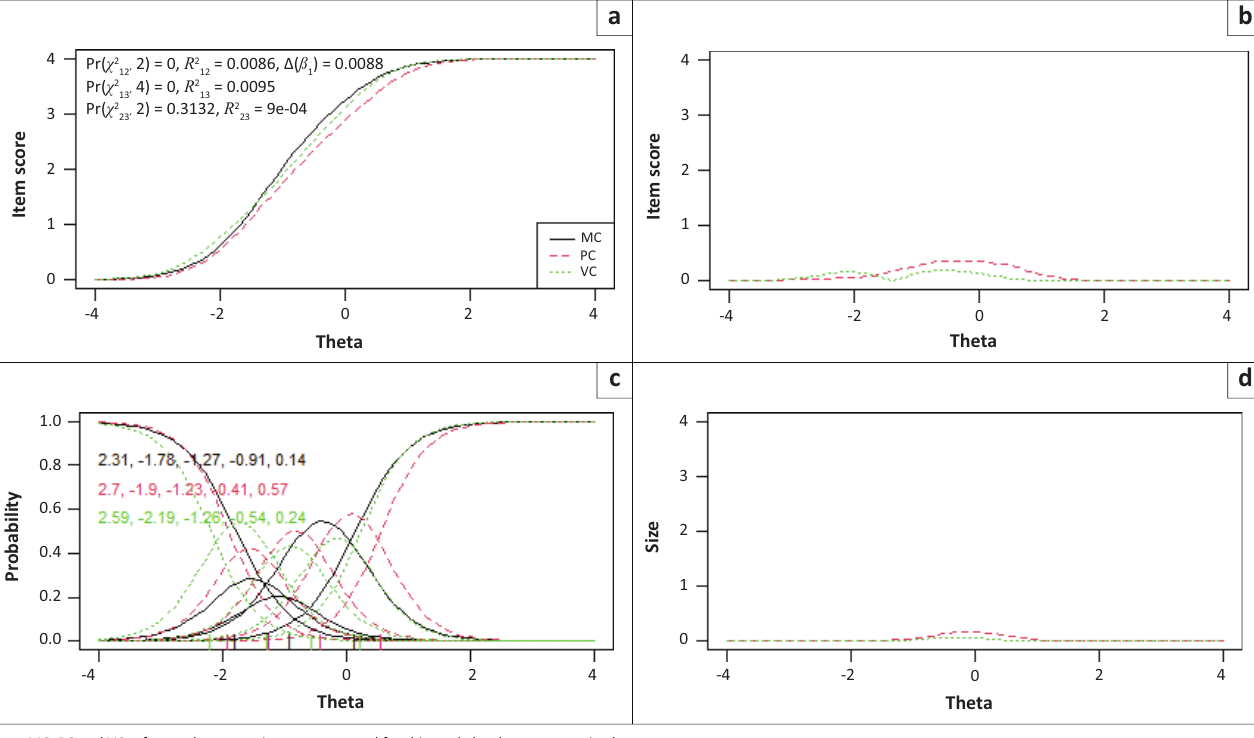
FIGURE 6: Graphical display of Item 7, which shows uniform and non-uniform differential item functioning with respect to campuses. (a) Items True Score Functions - item 7; (b) differences in items True Score Functions; (c) Item Response Functions; (d) Impact (weighed by